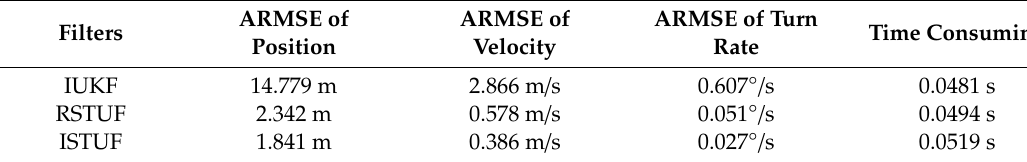
Table 2. The ARMSE and time consuming of the three